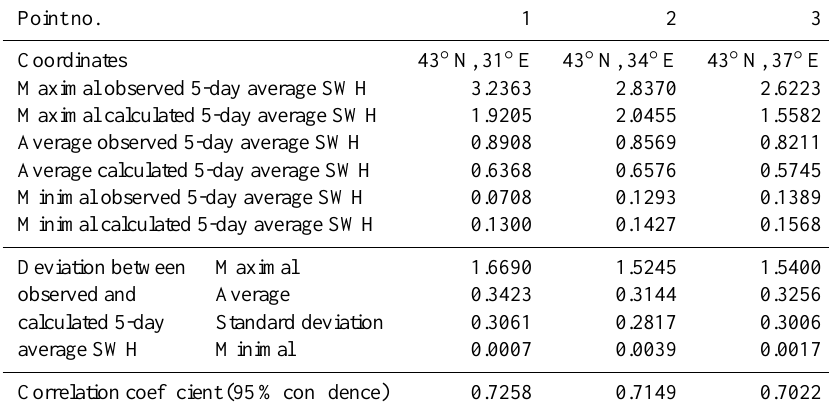
Table 1. General statistical parameters of calculated against observed SWH values. Point